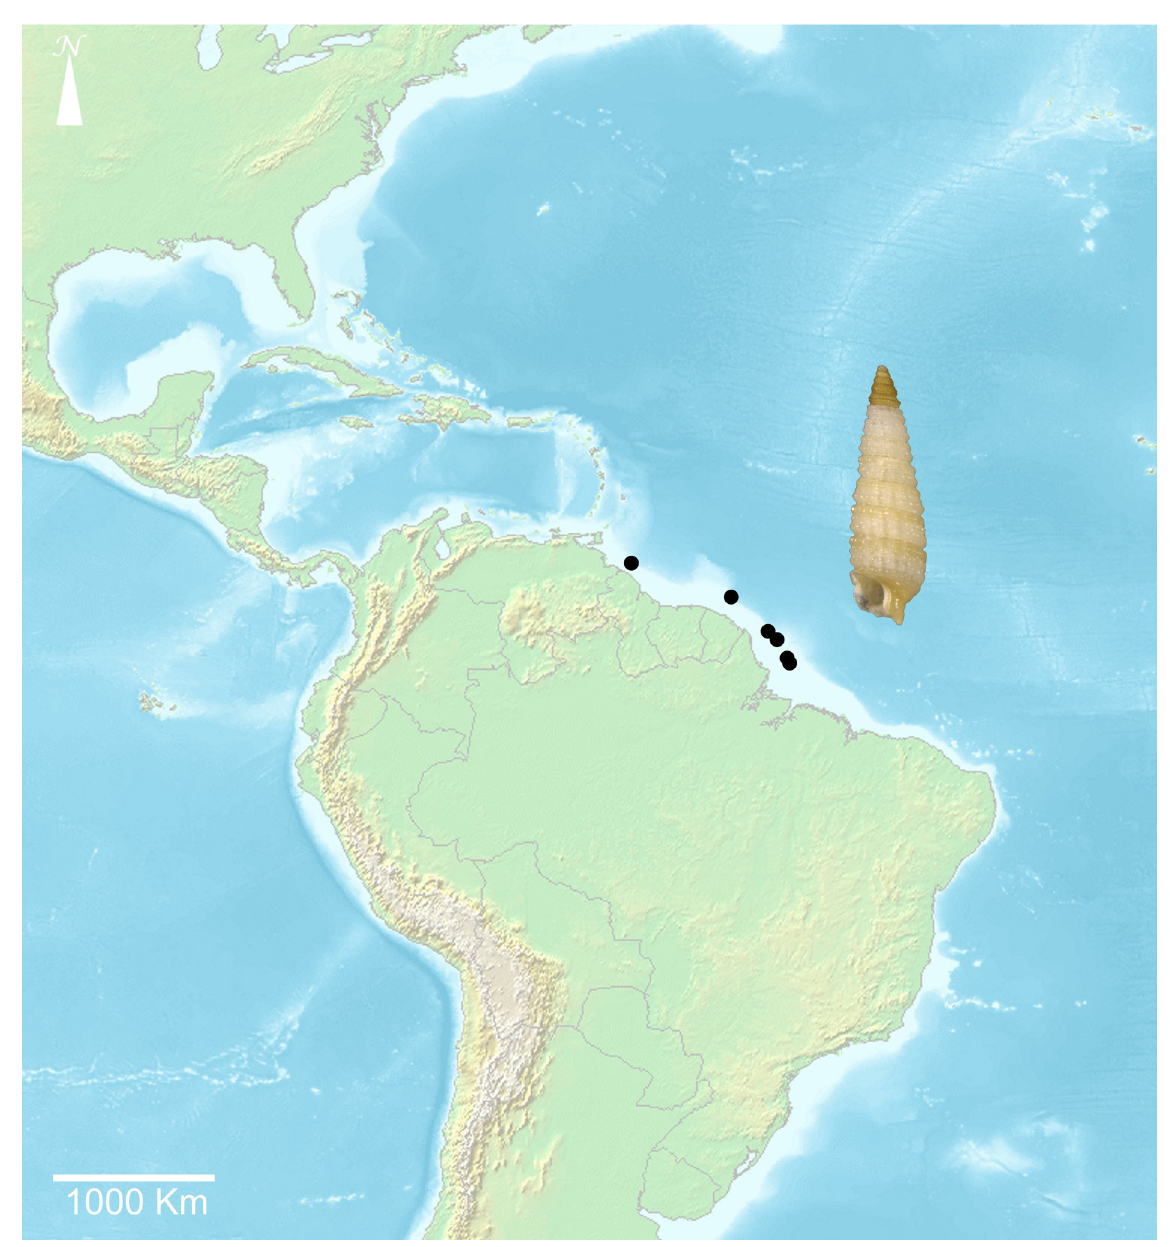
Fig. 67. Distribution map of Similiphora